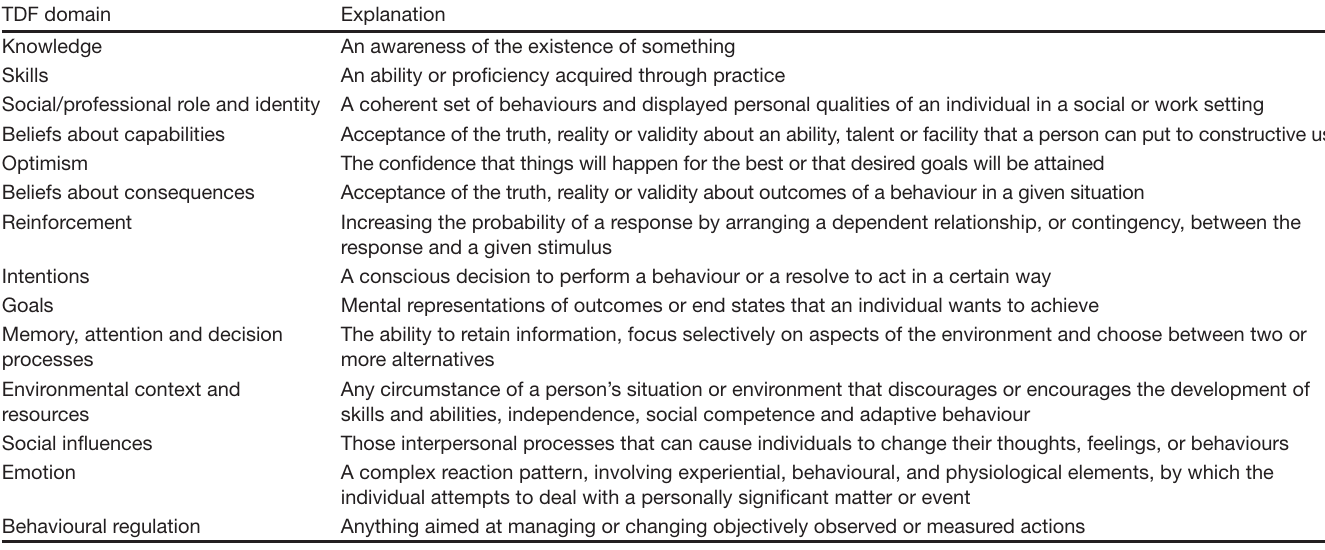
Table 1. The Theoretical Domains Framework – 14 domains of individual, socio-cultural and environmental influences on a behaviour [19] TDF